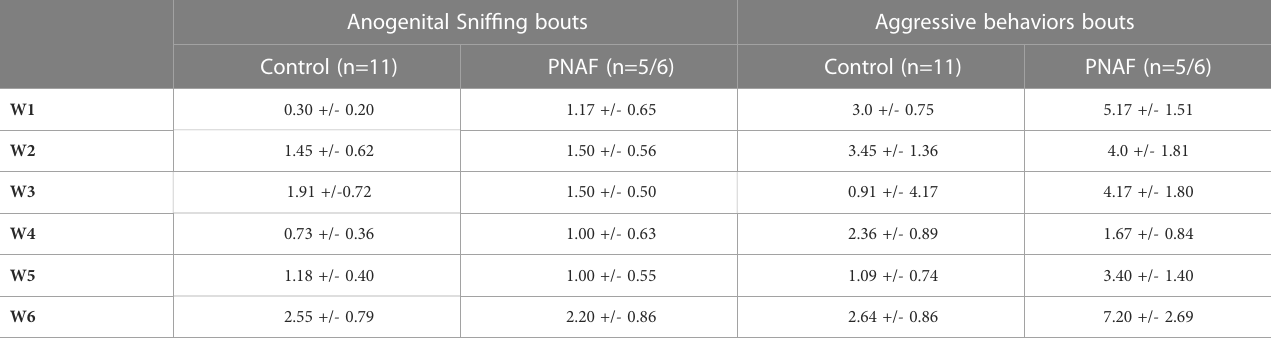
TABLE 3 Prenatal DHT exposure does not affect investigative and aggressive behaviors in the adult female mice. Mean +/- SEM. W, week; PNAF, prenatally-androgenized female. Mean +/-